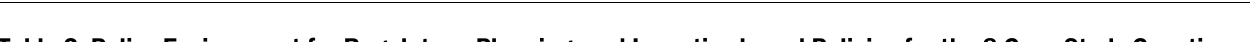
Table 2. Policy Environment for Regulatory, Planning, and Incentive-based Policies for the 8 Case-Study Counties Policy Weight Cache